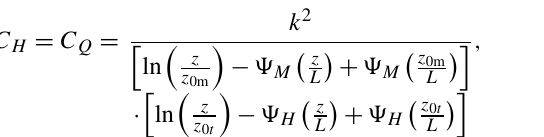
Table 2. Melting and evaporation rates in Ny-Ålesund and Advent- dalen, calculated from the heat